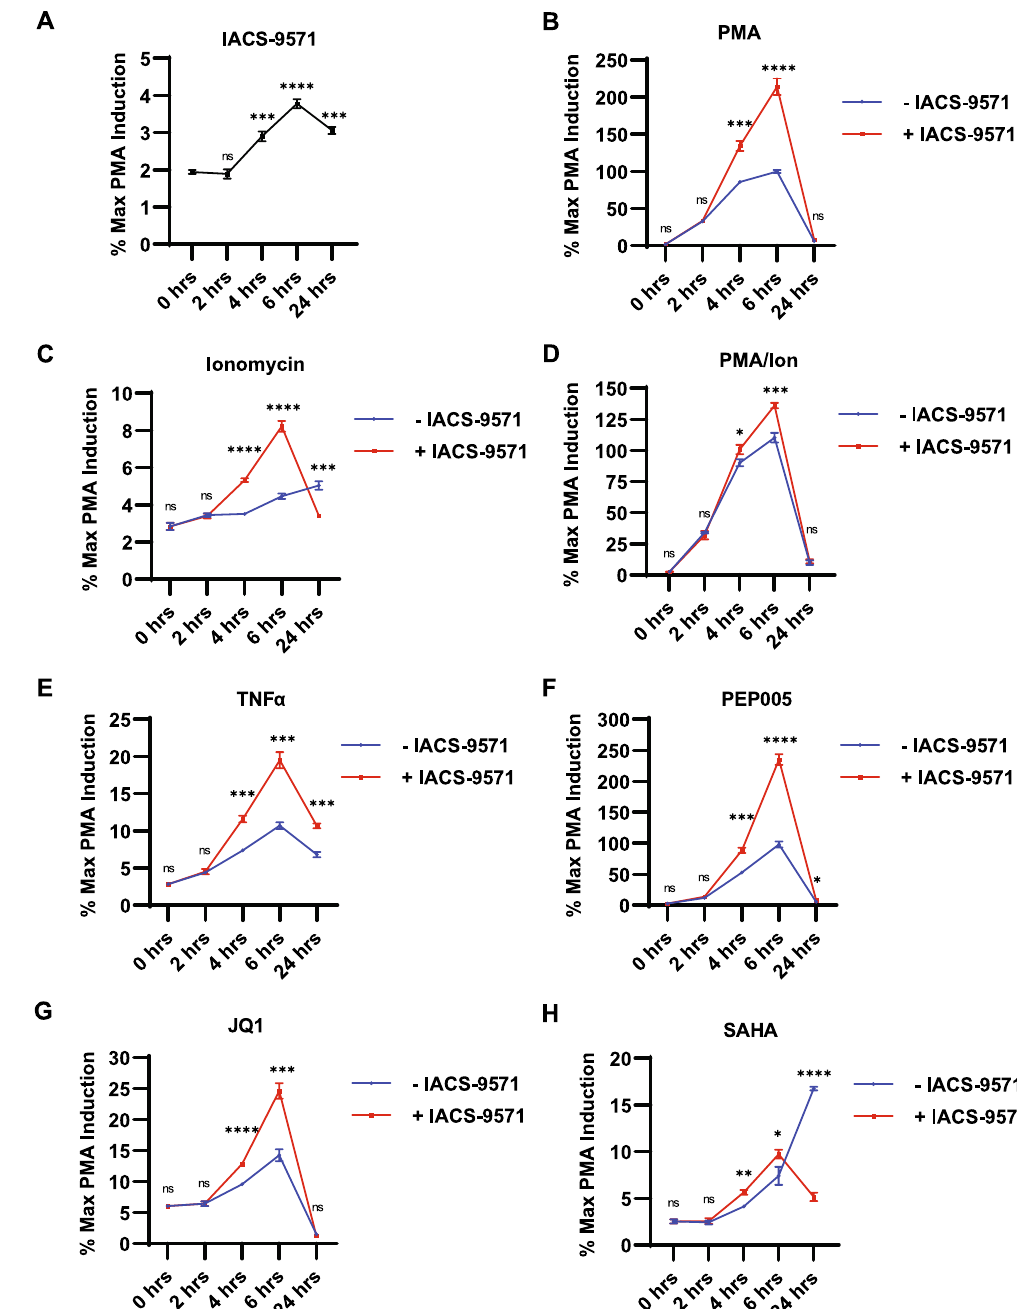
Figure 3. IACS-9571 causes synergistic activation T cell signaling agonists. ( A – H ) Jurkat Tat mHIV-Luciferase cells were treated with the indicated latency reversing agent, with or without 10 µM IACS-9571. Luciferase assays were performed at the indicated times. Results of three determinations are displayed, with error bars representing standard deviation. Concentration of agonists used were 20 nM PMA, 1 µM ionomycin, 10 ng/µL TNFα, 20 nM PEP005, 10 μM JQ1, 10 μM